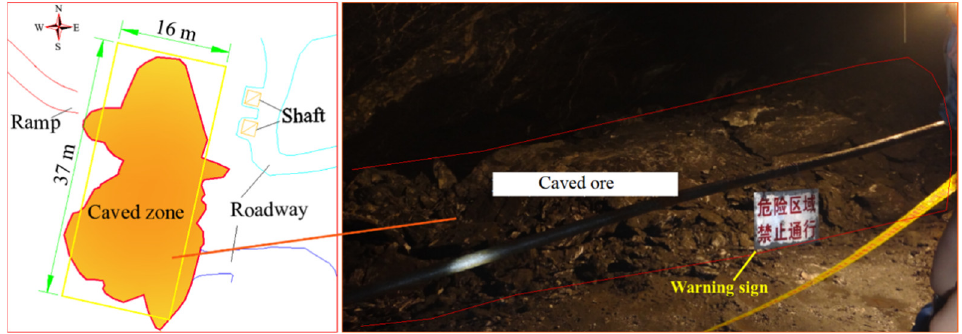
Figure 2. Caving induced by blasting.